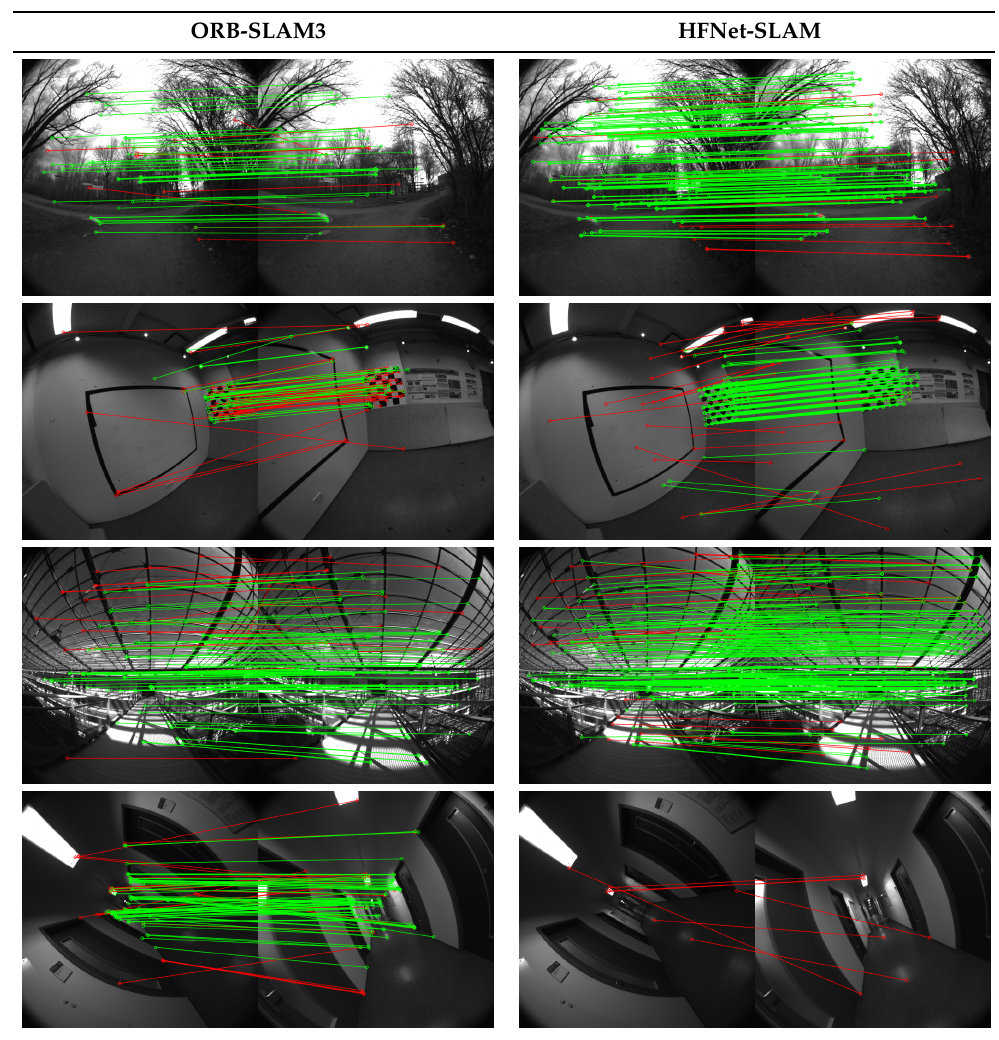
Figure 10. Qualitative results on feature matching. The green lines denote correct matches, while the red lines denote outliers. Row 4: Failure case due to extreme in-plane